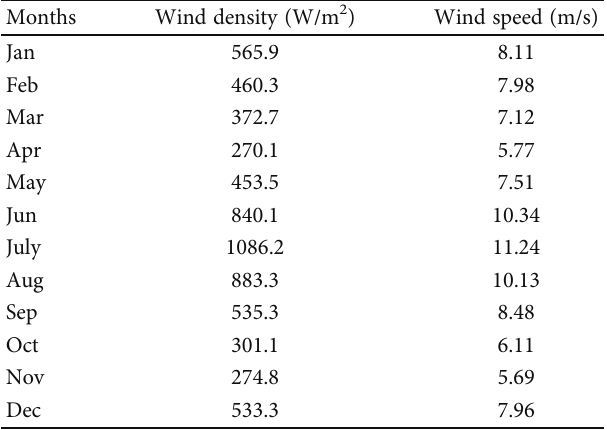
Data Availability Table 8: Monthly wind density and speed of Afar region.